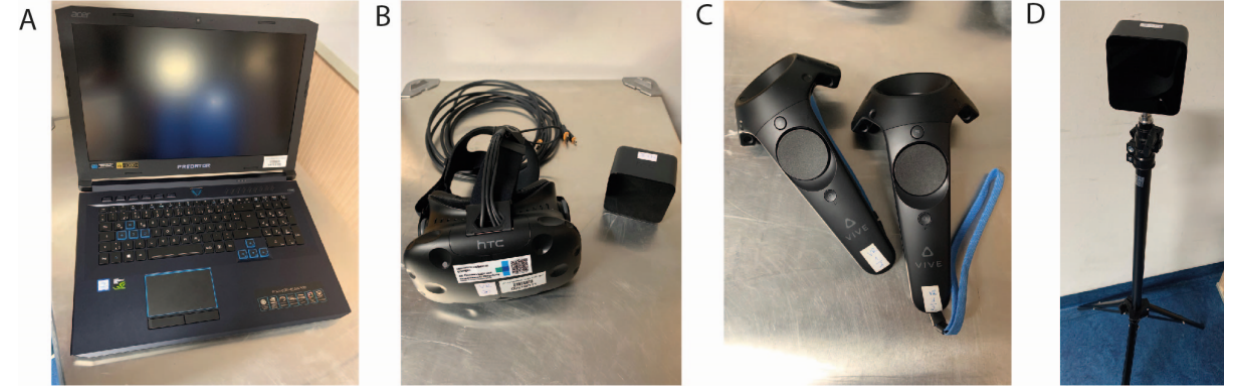
Figure 2. Applied technical virtual reality (VR) equipment. For the VR experience, a Notebook (Acer Predator Helios 500) (A), VR set (VR Headset HTC VIVE) (B), motion controller (C), and Lighthouse Tracking (D) are